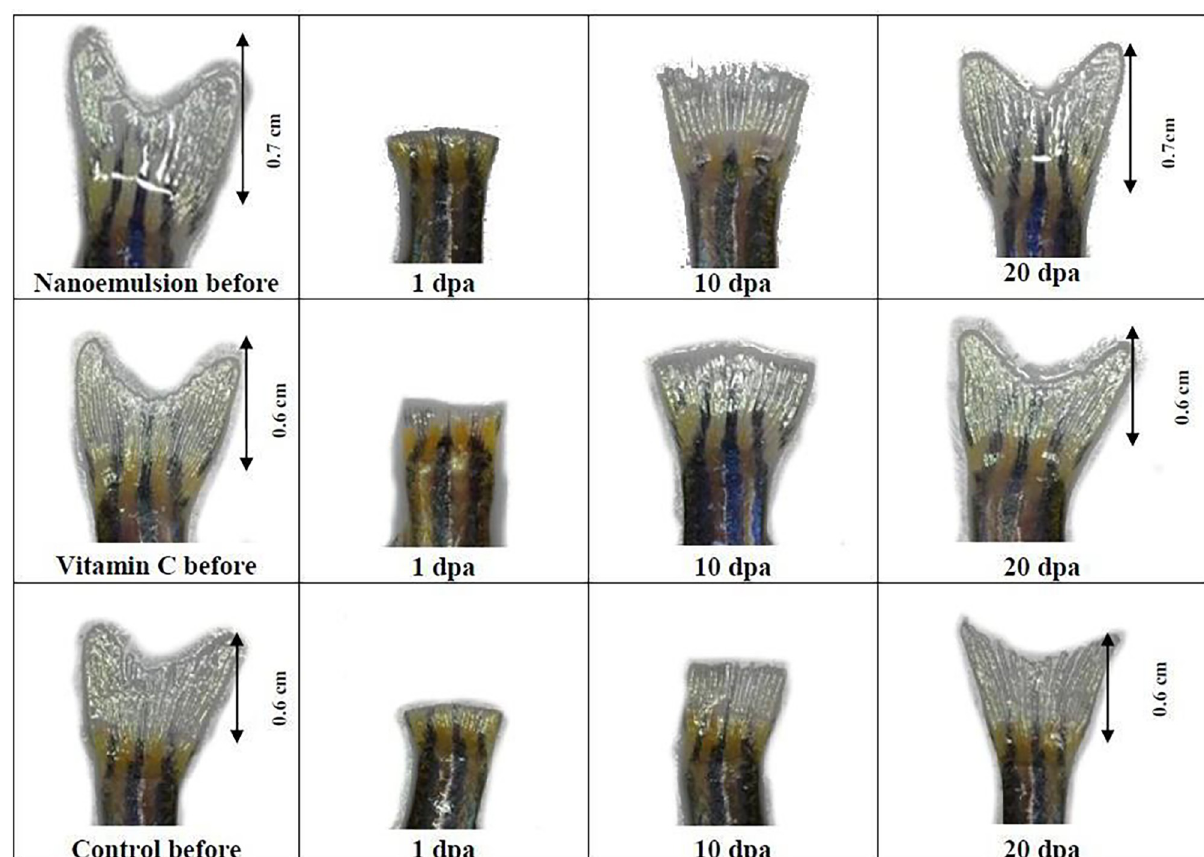
Fig 9. Adult zebrafish tail regeneration before and after